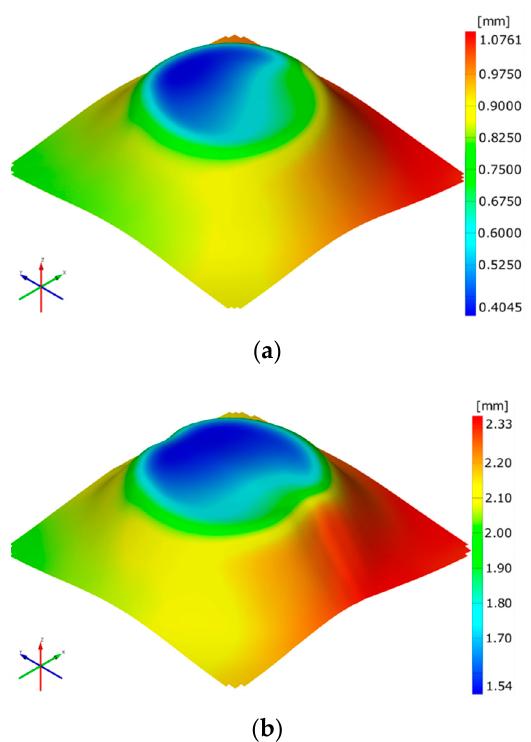
Figure 11. The springback variation for unwelded blanks ( a ) and double side welded blanks ( b ) for truncated cone-shaped parts.